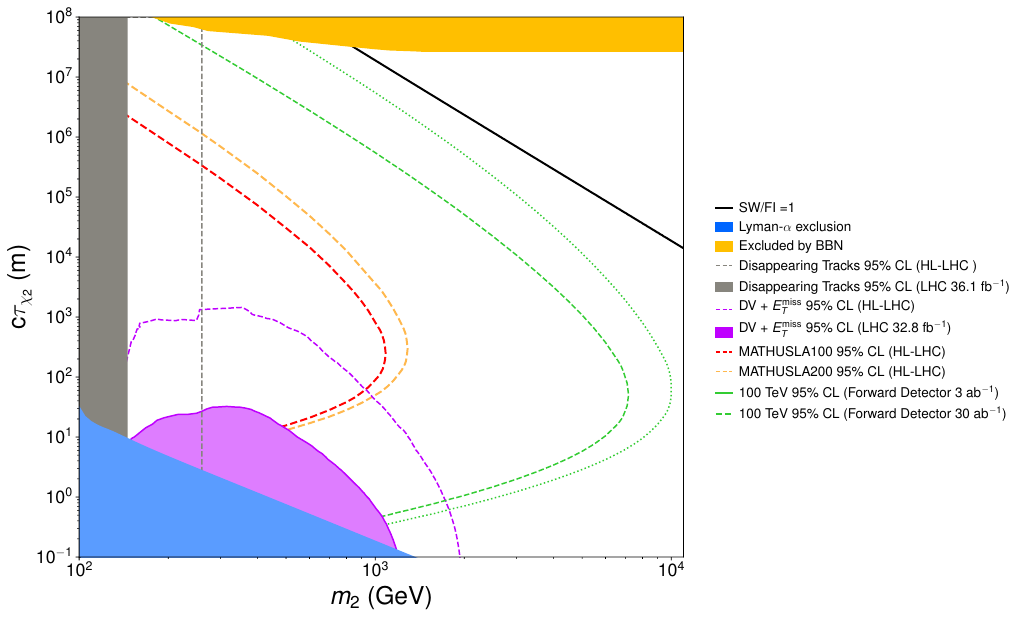
Figure 10 . FCC-hh forward detector 95% C.L. sensitivity projections ( N events = 3) for = 3 L ab (cid:0) 1 (dashed-green line) and = 30 ab (cid:0) 1 (dotted-green line). Shown for comparison are the L MATHUSLA100 (dashed-red line) and MATHUSLA200 (dashed-orange line) sensitivity projections (background-free environment assumed, corresponding to N events = 3) with = 3 ab (cid:0) 1 from L section 5, the present 13 TeV ATLAS DV + E miss search exclusion limits (purple region) and the T extrapolation to HL-LHC (dashed-purple line) from section 6.3, as well as the present exclusion limits from disappearing track searches (grey region) and their extrapolation to HL-LHC (vertical dashed-grey line) from section 6.2. Also shown are the bounds from Lyman- (cid:11) (blue region) and BBN (yellow region), and the boundary of the super-WIMP parameter-space region (solid-black line), given by SW/FI= 1 (recall (cid:12)gure 4 and the discussion in section